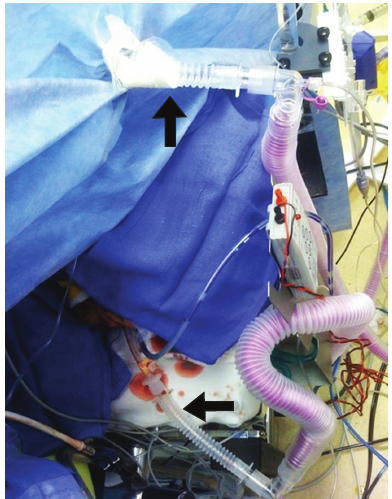
Figure 2: An oral endotracheal tube and a second cross field ventilation circuit that is passing through the drapes.